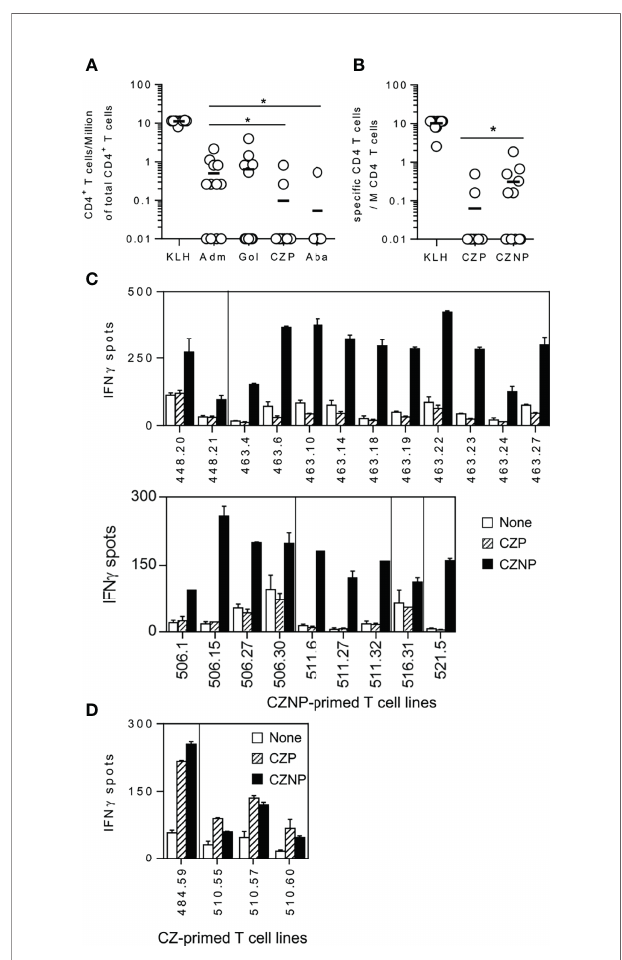
FIGURE 1 | Comparison of the size of T-cell repertoire speci fi c for therapeutic proteins in healthy donors. CD4 T-cell lines were generated by co-culturing CD4 T-cells with autologous DC loaded with each antibody. After 3 weeks, speci fi city of the T-cell lines were assessed by Elispot IFN- g . CD4 T-cell lines were considered as speci fi c when a spot count of duplicates was 2-fold higher in the presence of the protein (3µM) than in their absence, with a minimal difference of 25 spots. Frequencies of speci fi c CD4 T-cells was estimated using the Poisson distribution according to the following formula: Frequency = -Ln((number of negative wells/total number of wells tested))/(number of CD4+ T-cells/well). (A) T-Cell frequencies evaluated with cells collected from 12 donors for Adalimumab, Golimumab, Certolizumab pegol and Abatacept. (B) comparison of T-cell frequencies between Certolizumab pegol (CZP) and its non-pegylated counterpart (CZNP). Speci fi c T-cell lines raised against (C) CZNP (D) CZP were tested by Elispot with unloaded DCs (open bars), DCs loaded with CZP (hatched bars) and CZNP (black bars). Wilcoxon signed-rank test: *p <